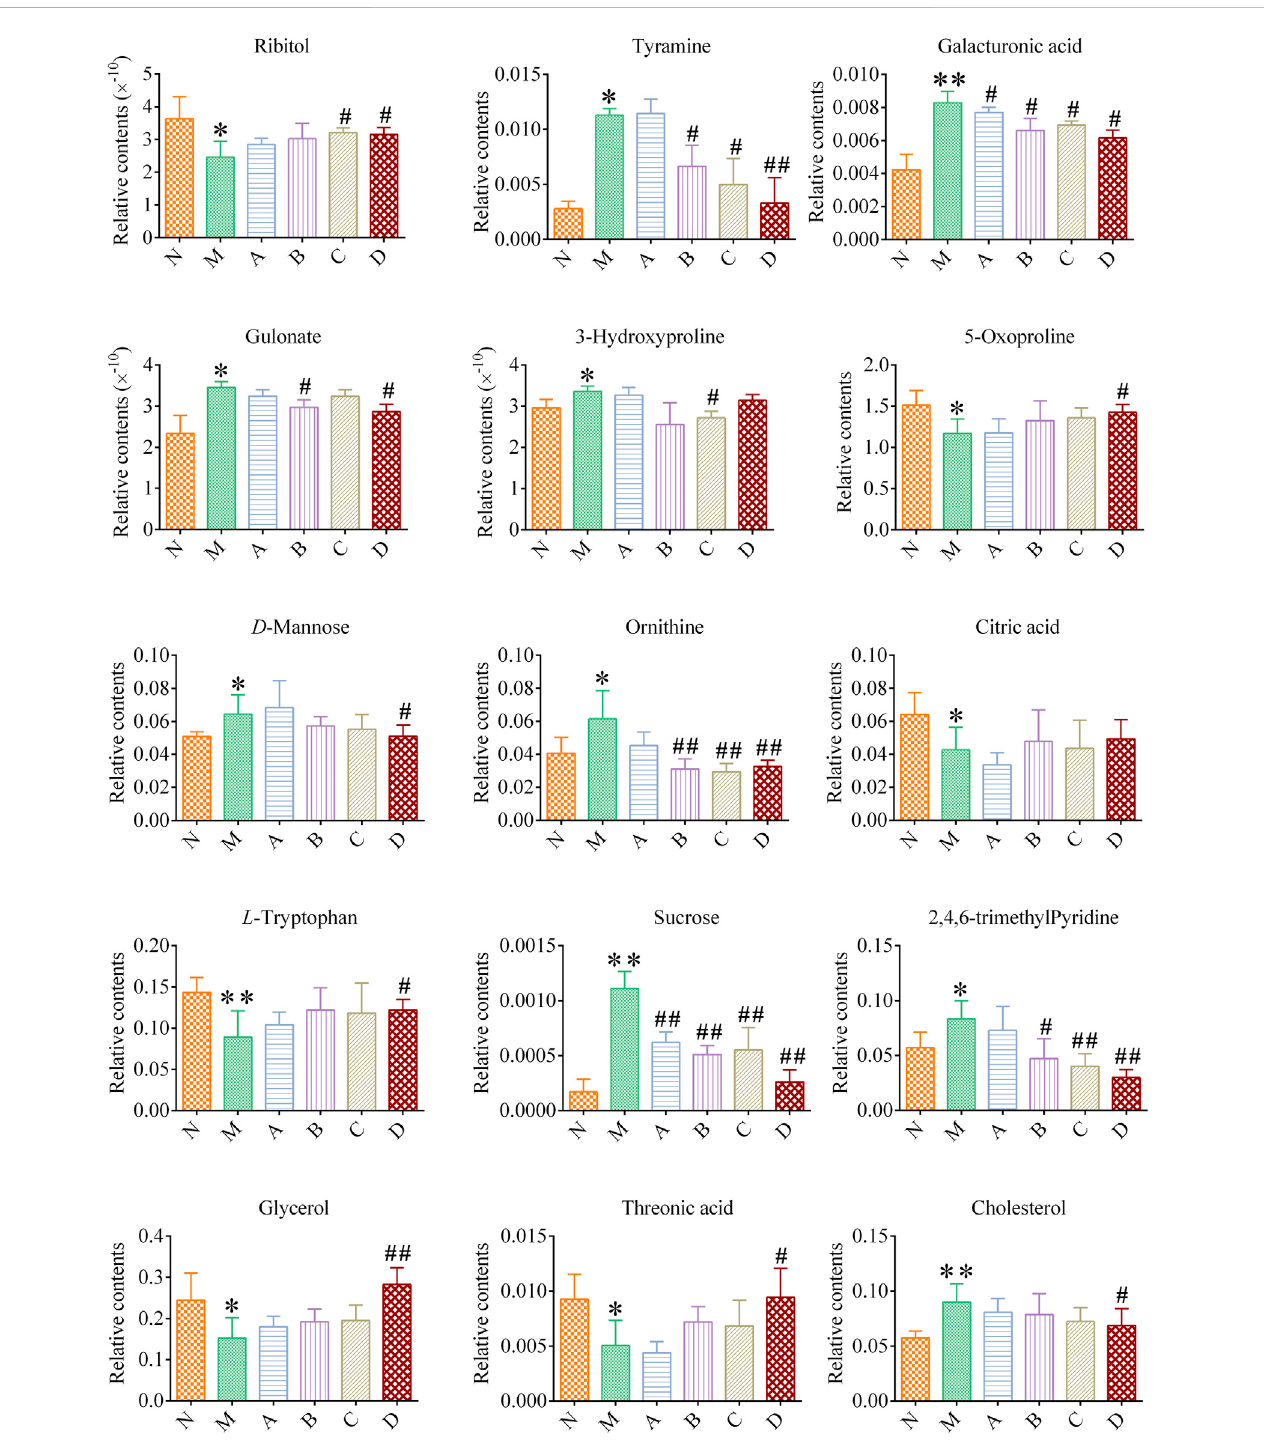
FIGURE 6 The levels of potential biomarkers of kidney-yang de fi ciency in each group Compared with the N group, * p < 0.05, ** p < 0.01; compared with the M group, # p < 0.05, ## p <